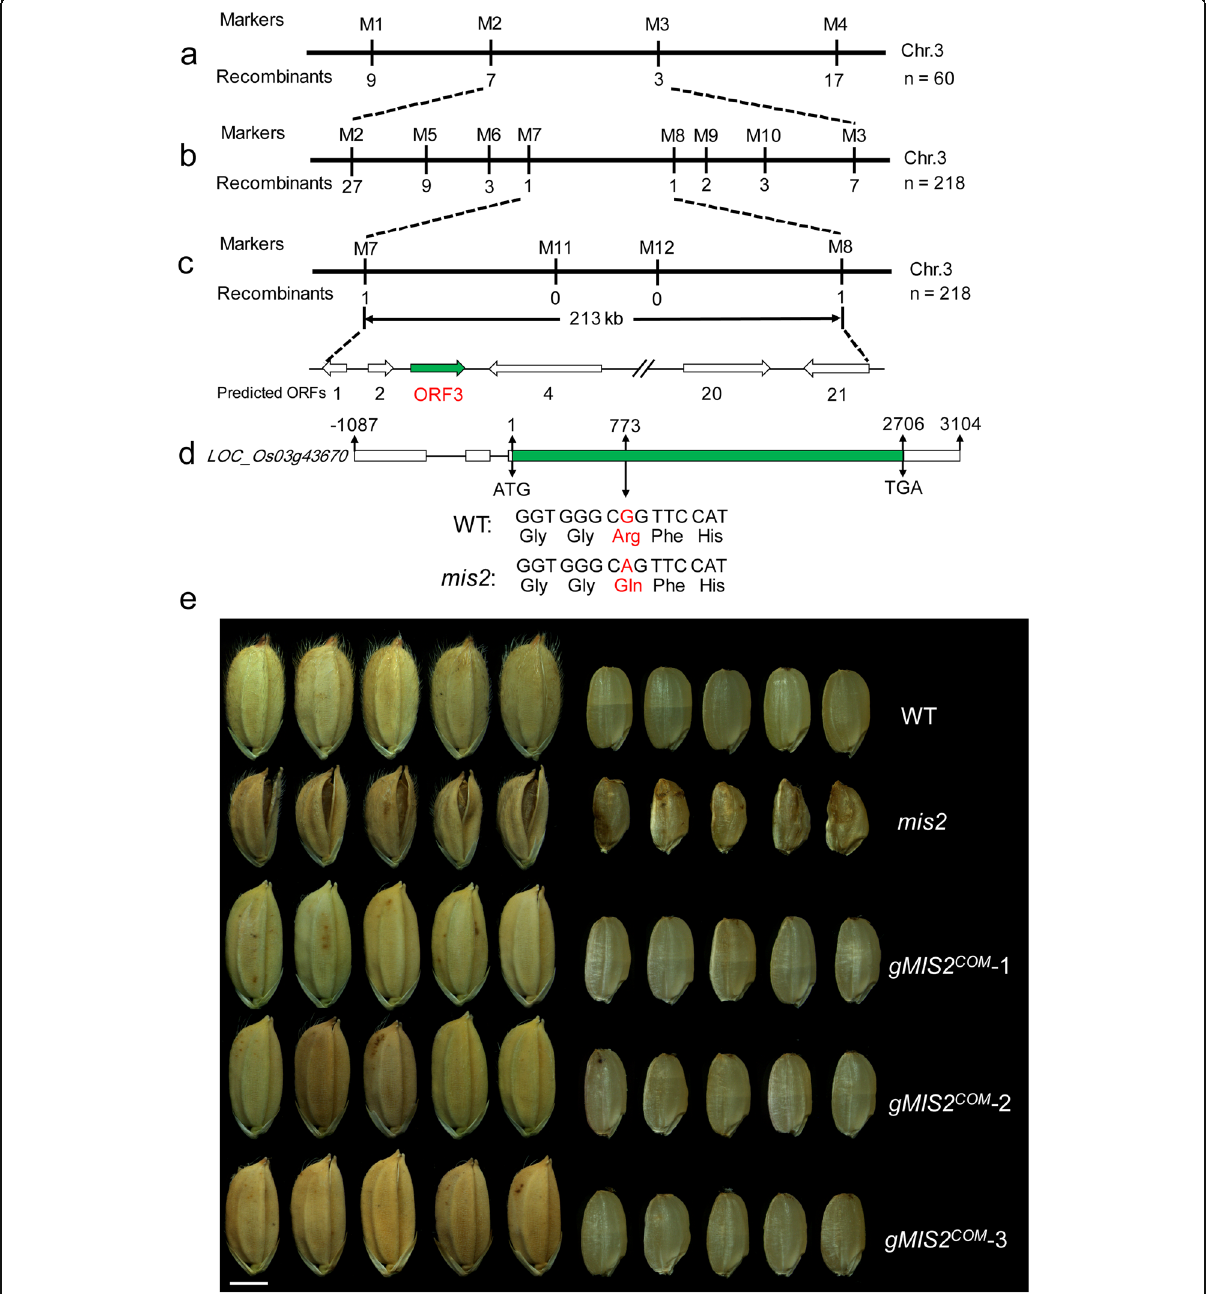
Fig. 5 Map-Based cloning of MIS2 and genetic complementation. ( a ) The MIS2 locus was mapped to a region between markers M2 and M3 on chromosome 3. ( b , c ) The candidate gene was further delimited to a 213-kb genomic region between markers M7 and M8. Twenty-one candidate genes are predicted in this region. The numbers beneath the marker positions indicate the number of recombinants. ( d ) The MIS2 gene structure. White and green box represent untranslated region and coding sequence, respectively. Black lines represent introns. The start codon (ATG) and the stop codon (TGA) are indicated. A single nucleotide mutation from G to A in MIS2 resulted in an arginine-to-glutamine change. ( e ) Complementation of mature grain morphology. Three genomic DNA complementation transgenic lines are shown. Bar = 2.5